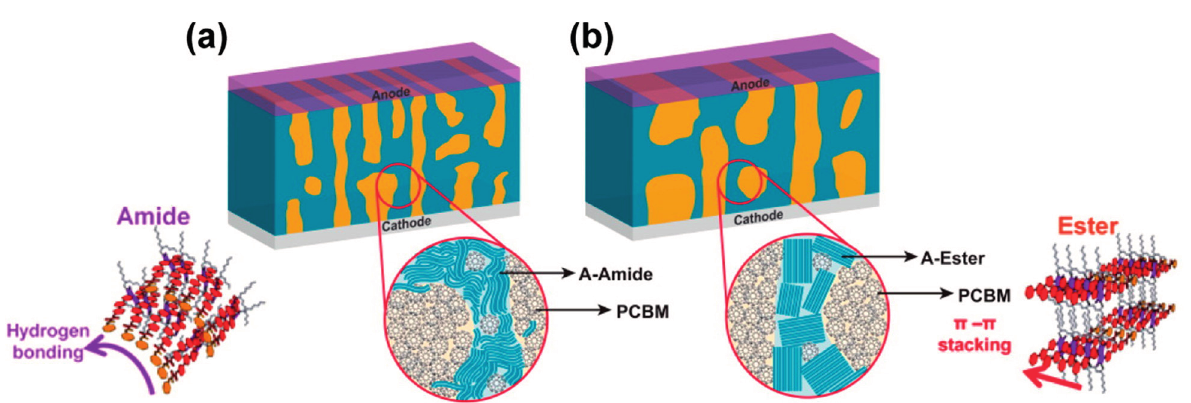
Figure 11. Packing structure and active layer morphology for: ( a ) amide-DPP; and ( b ) ester-DPP. Adapted from [133] with permission the American Chemical